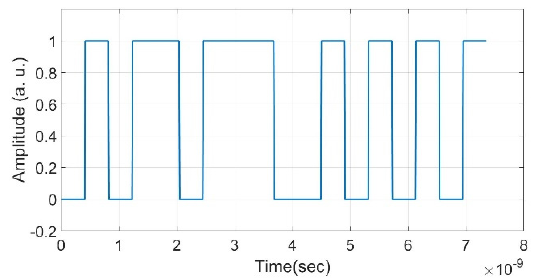
Figure 6. Digital data after the debugging and normalization process.